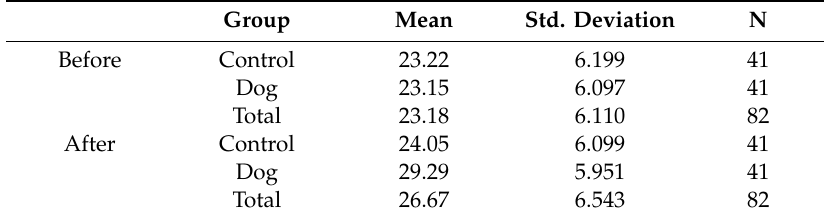
Table 5. Descriptive Statistics: